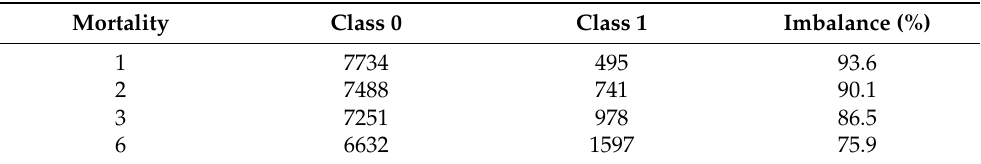
Table 1. Imbalance of samples for the prediction of mortality in patients in ESRD. Class 0 and Class 1 refer to samples in alive and deceased classes,